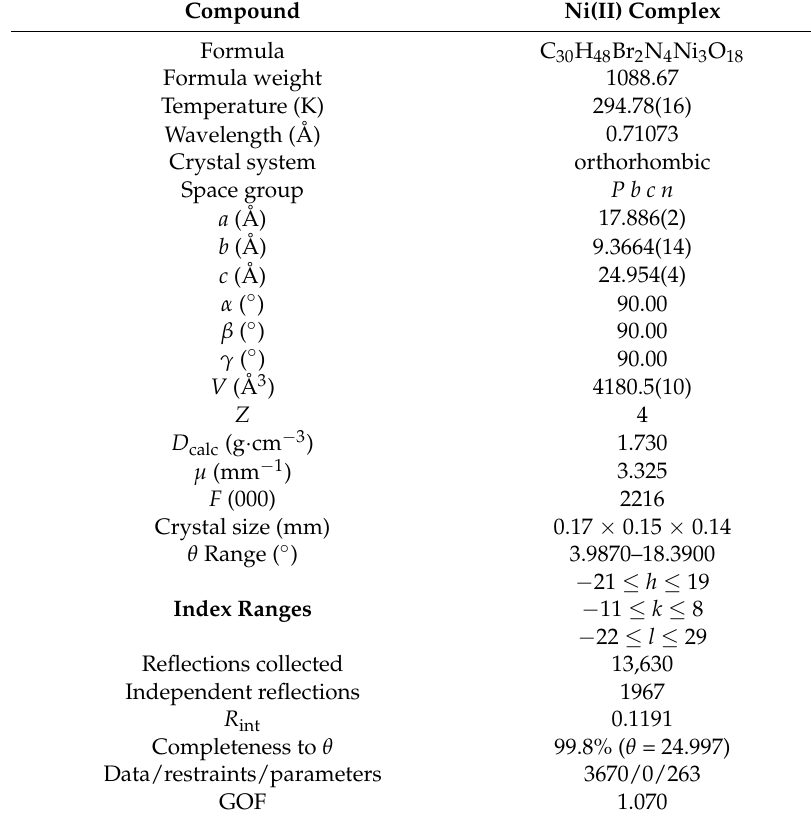
Table 1. Crystal data and refinement parameters for the Ni(II)